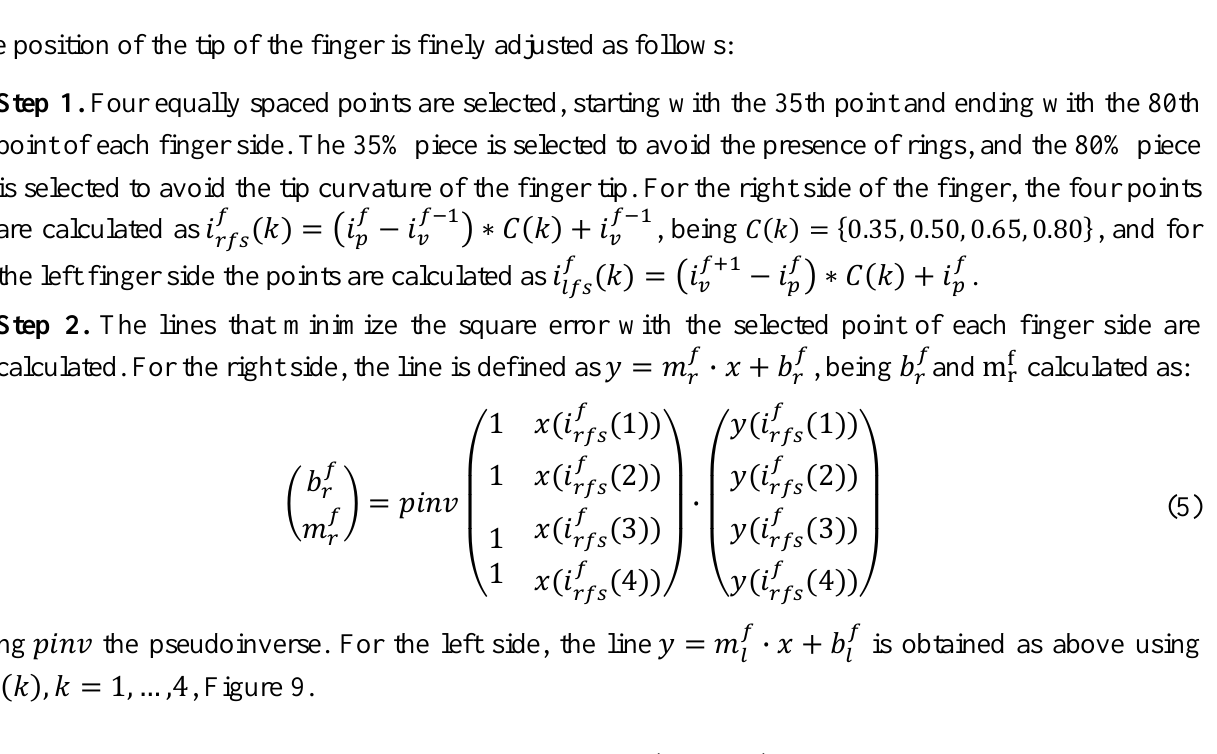
Figure 9. Initial tip localization and finger sides (in green); finger axis and accurate tip localization (in